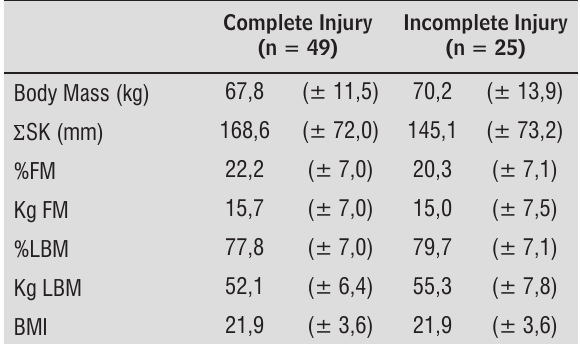
Table 4 – Results of the evaluation for complete and incom-